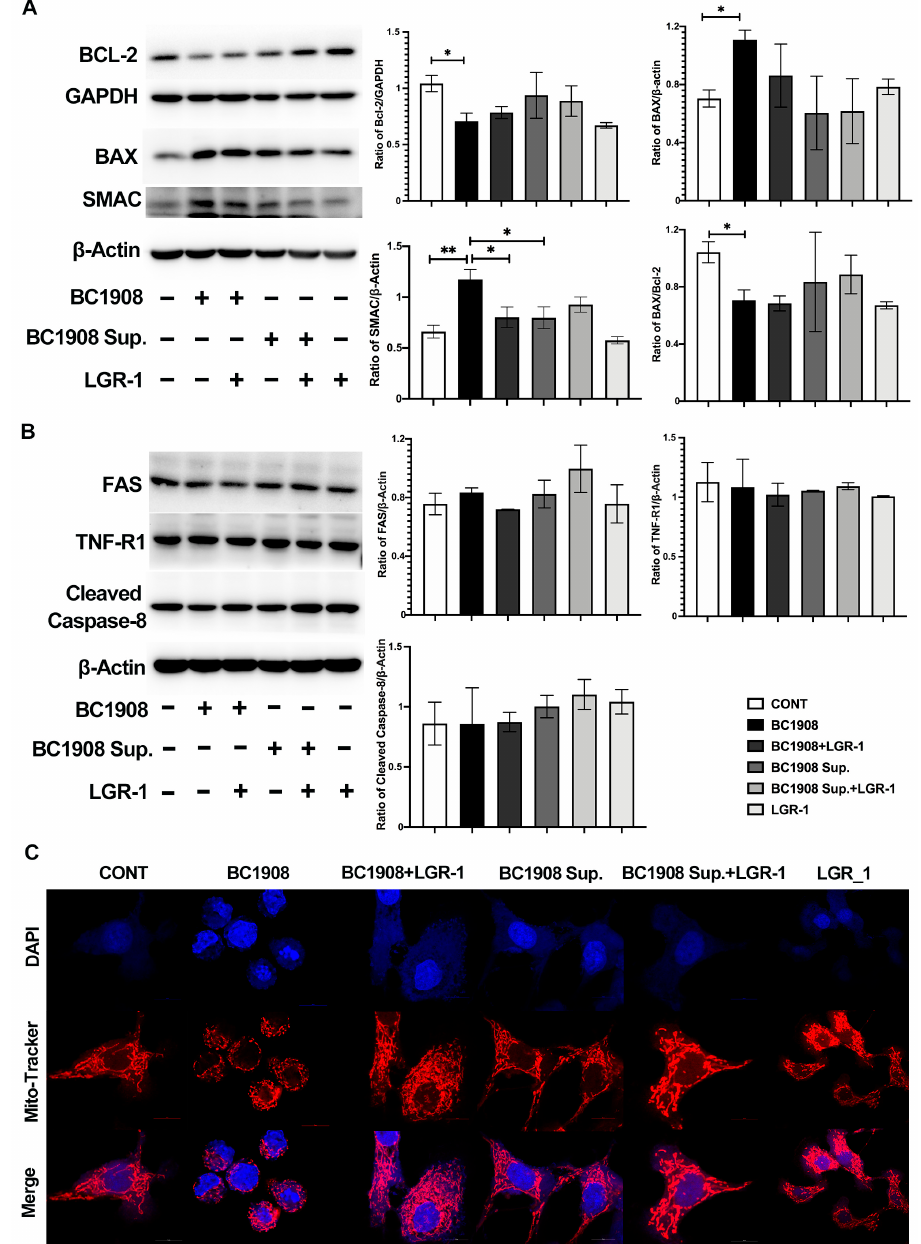
Figure 6. Further study on the apoptosis pathway of endometrial epithelial cells induced by B. cereus . ( A ) B. cereus activated the apoptotic pathway by the mitochondrial pathway. ( B )